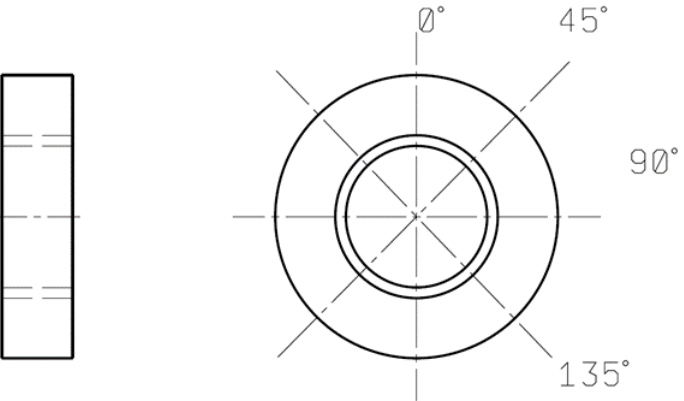
Figure 2. The measurement scheme.